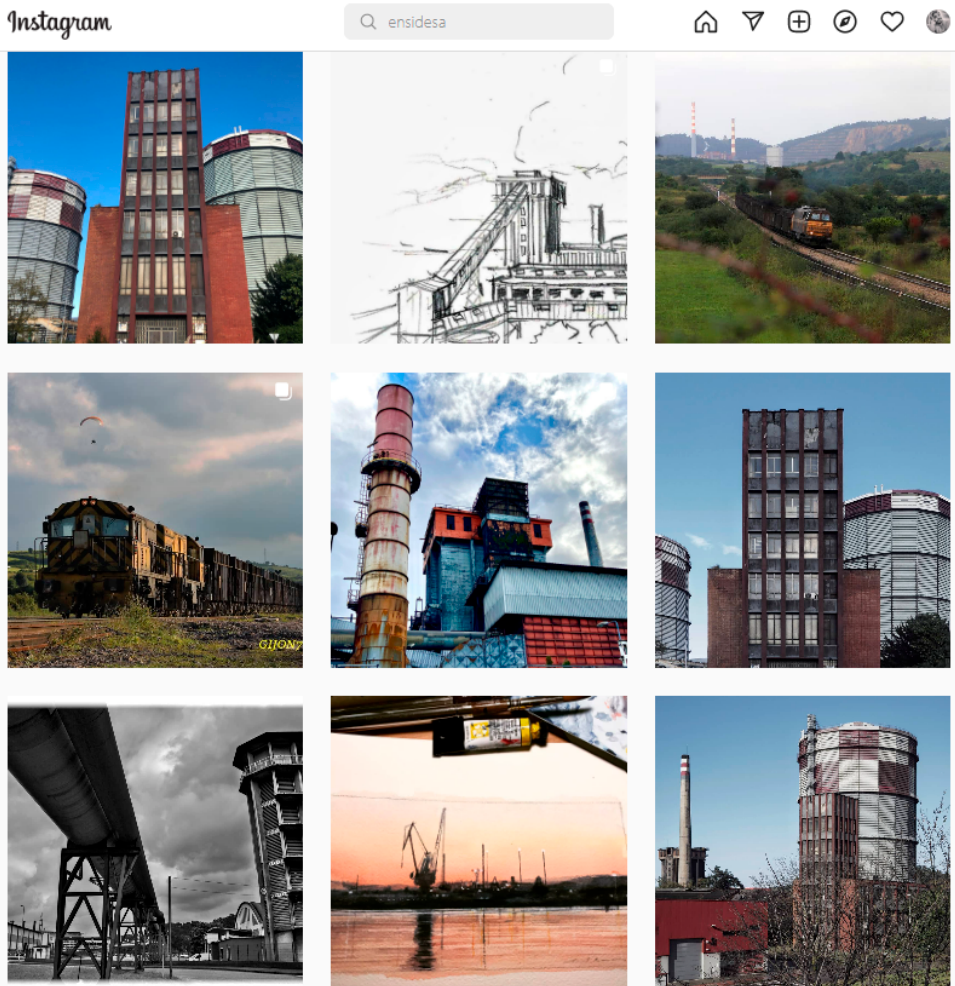
Figure 3. Some Instagram photos tagged with the hashtag ENSIDESA.